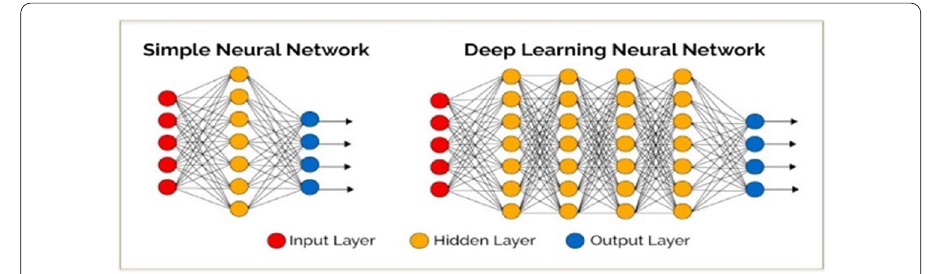
Fig. 1 Simple neural networks and deep networks